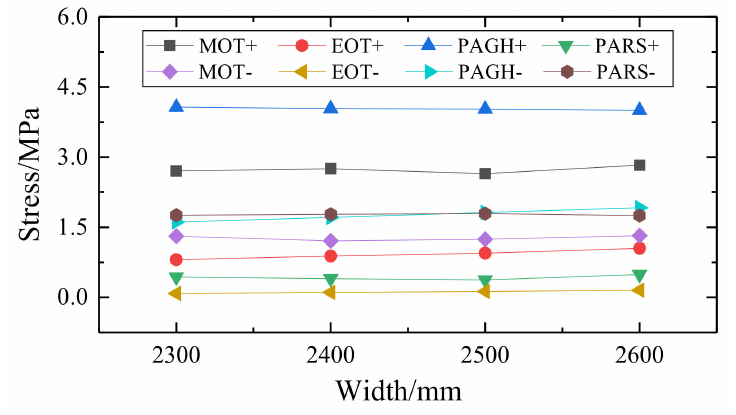
Figure 18. Influence of width on temperature stress of track slab (In legend identification, “+” means positive temperature gradient; “ − ” means negative temperature gradient).